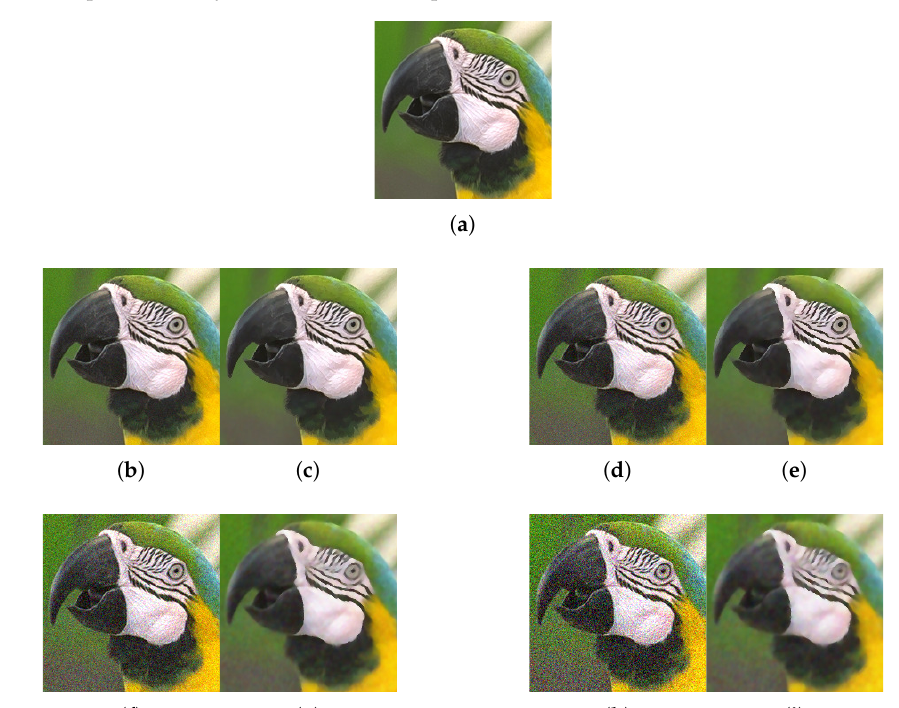
Figure 12. Method outputs using test image Parrots contaminated with various intensities of Gaussian σ . ( a ) Parrots. ( b ) Noisy σ = 5. ( c ) Filter output. ( d ) Noisy σ = 10. ( e ) Filter output. ( f ) Noisy σ = 20. ( g ) Filter output. ( h ) Noisy σ = 30. ( i ) Filter